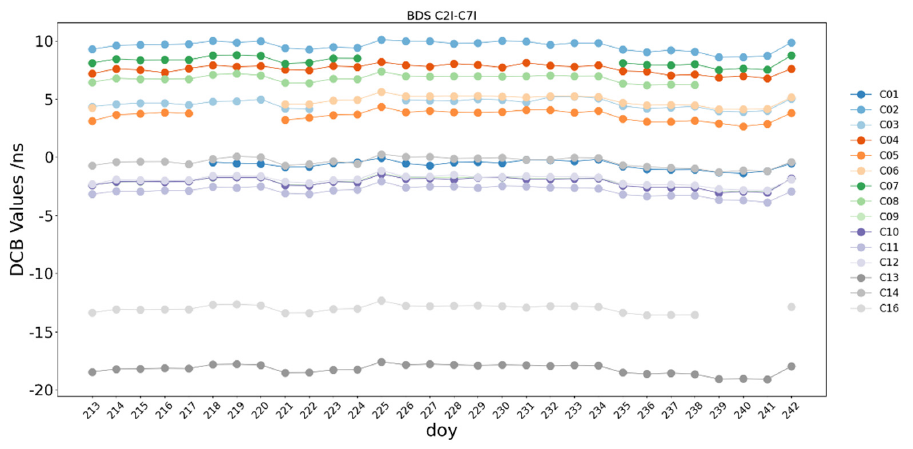
Figure 25. C2I–C7I DCB time series of BDS satellites.